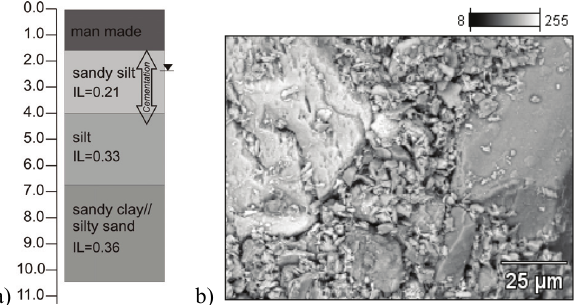
Fig. 4. The testing profile (a) SEM image of a soil sample (b)